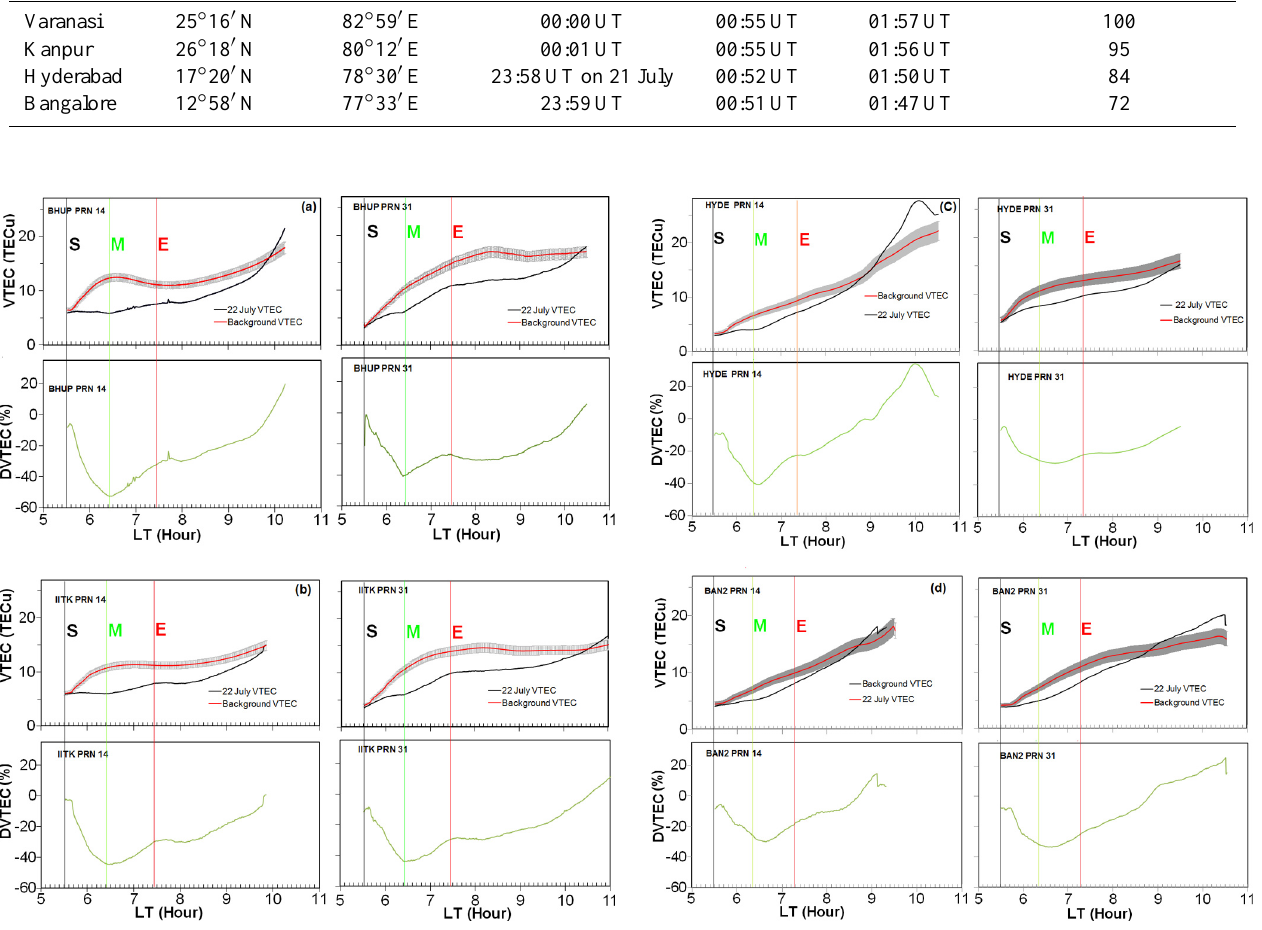
Fig. 2. Variation of VTEC compared to quiet mean VTEC and percentage change in VTEC compared to quiet mean VTEC (DVTEC) estimated from PRNs 14 and 31 data during total solar eclipse period at (a) Varanasi (BHUP), (b) Kanpur (IITK), (c) Hyderabad (HYDE) and (d) Bangalore